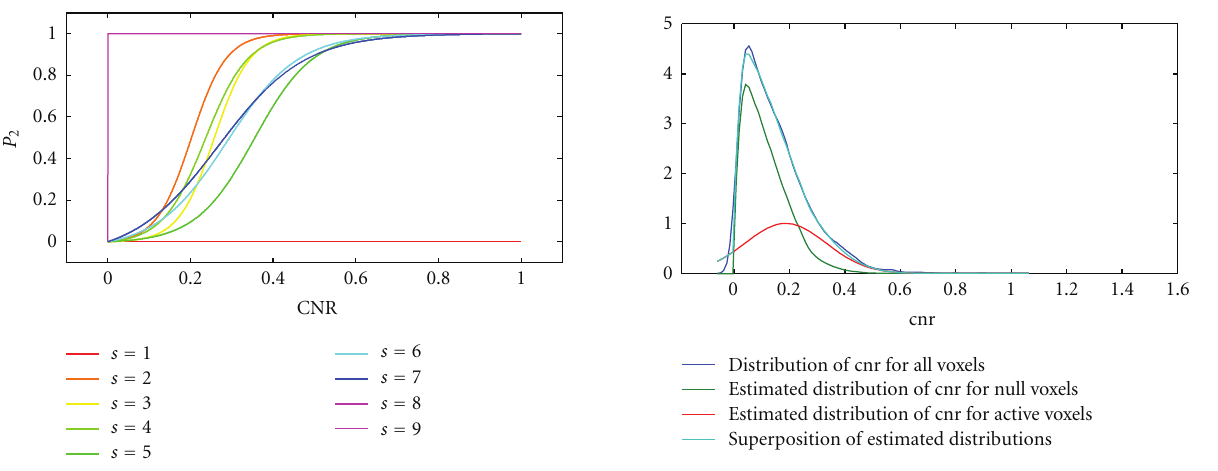
Figure 5: Density estimation of active and inactive voxels in (cid:14) ∞ p ( ω ,CNR | memory activation data. The top curve (dark blue) shows the Figure 3: Estimation of P 2 ( ω 0 ,CNR, s , M ) = ω 0 (cid:14) ∞ distribution of the cnr using kernel density estimation techniques. s , M ) dω/ p ( ω ,CNR | s , M ) dω from motor activation data using 0 The green and red curves are the estimated distributions of the numerical integration for all configurations of size s ∈ { 1, ... ,9 } cnr for the inactive and active voxels, respectively. Note that for cCCA with the maximum constraint. The joint probability the distribution of the inactive voxels (green curve) was derived density p ( ω ,CNR | s , M ) in the integrands are determined with from wavelet resampled resting-state data using a dilation variable, 2D kernel density estimation using a 2D Gaussian kernel (for an whereas the distribution of the active voxels (red curve) was example see Figure 2). Note that for CNR > 0 . 6, P 2 approaches the derived from a Gaussian distribution. The mixture of the estimated value 1 rapidly for all s / = 1. This relationship is also true for data distributions for null and active voxels is given by the light blue obtained from the memory experiment. Note that configurations curve showing very small di ff erences to the raw curve (dark with s = 1 have no significance in contributing to the smoothing artifact because the smoothing artifact is by definition equal to zero for s = 1.